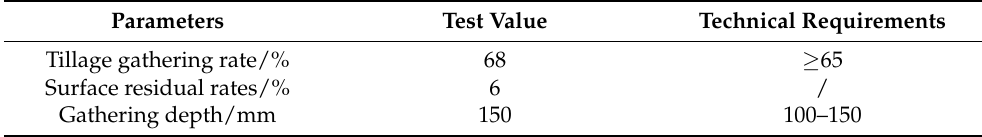
Table 1. Performance of the chain drive film soil separation mechanism. Parameters Test